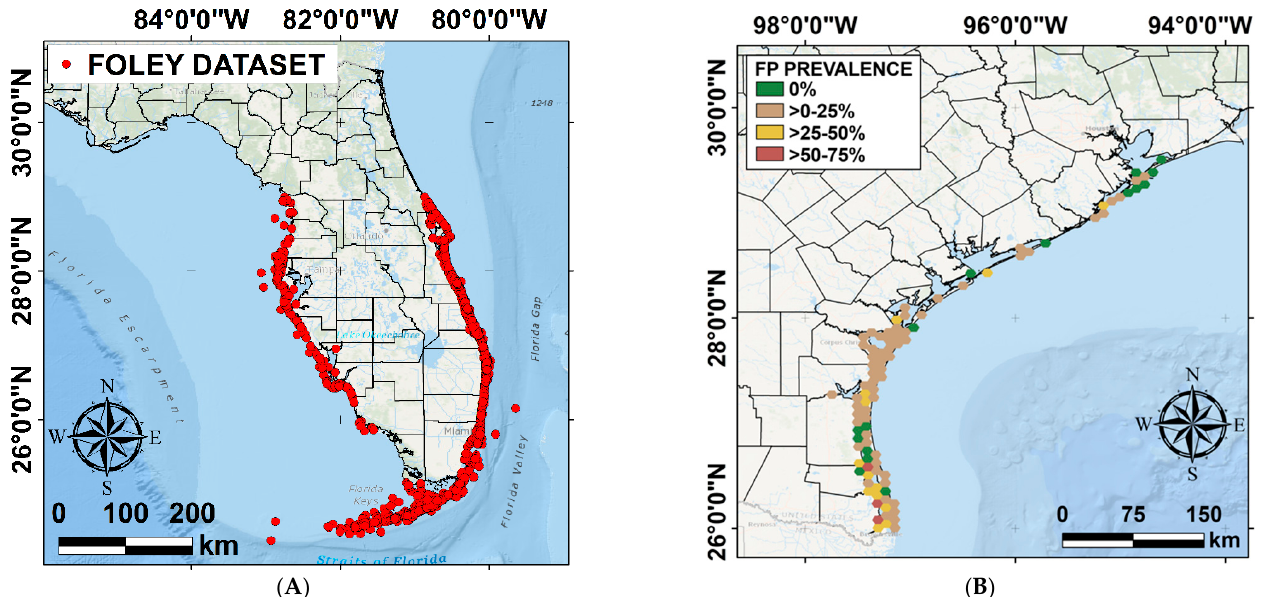
Figure 2. ( A ) Distribution of the surveyed turtles between 1980 and 1998 [20]; ( B ) distribution and prevalence of surveyed turtles affected by FP in Texas from 2010 to 2018 (adapted from Shaver et al., 2019)